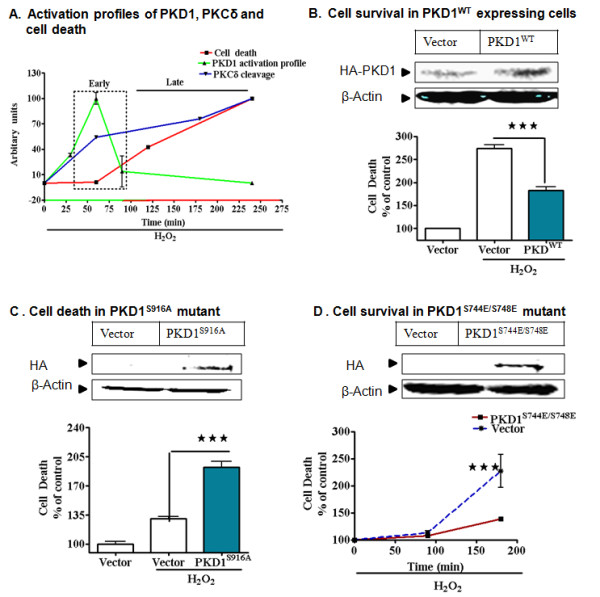
PKD1 activation acts as an early protective compensatory mechanism. A comparative time course graph based on quantifying PKD1 activation profile, PKCδ cleavage profile and cytotoxicity during H2O2 exposure (A). N27 dopaminergic cells transiently transfected with 5 μM full length PKD1 plasmid (PKD1WT) and 5 μM vector plasmid were treated with or without 100 μM H2O2 for 150 minutes and monitored for cytotoxicity using sytox green; PKD1 protected against cytotoxicity (B). N27 dopaminergic cells transiently transfected with 5 μM PKD1S916A plasmid and 5 μM vector plasmid were treated with or without 100 μM H2O2 for 150 minutes and monitored for cytotoxicity using sytox green; increased cytotoxicity was observed in the cells (C). N27 dopaminergic cells transiently transfected with 5 μM PKD1S744E/S748E and 5 μM vector plasmid (D) were treated with or without 100 μM H2O2 and monitored for cytotoxicity at various time points using sytox green. ***, p < 0.001 denotes significant difference between treatment groups from n≥6.